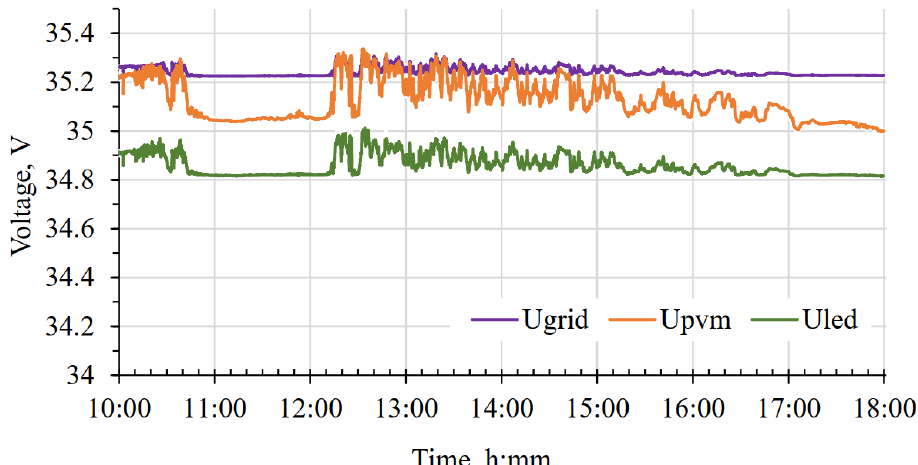
Figure 5. Solar radiation intensity.